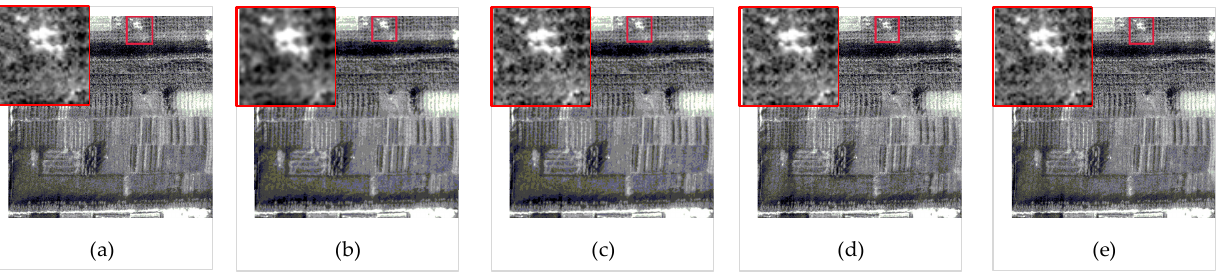
result of SSDC; ( d ) denoised result of MNEM-Order; ( e ) denoised result of MNEM-Ratio.